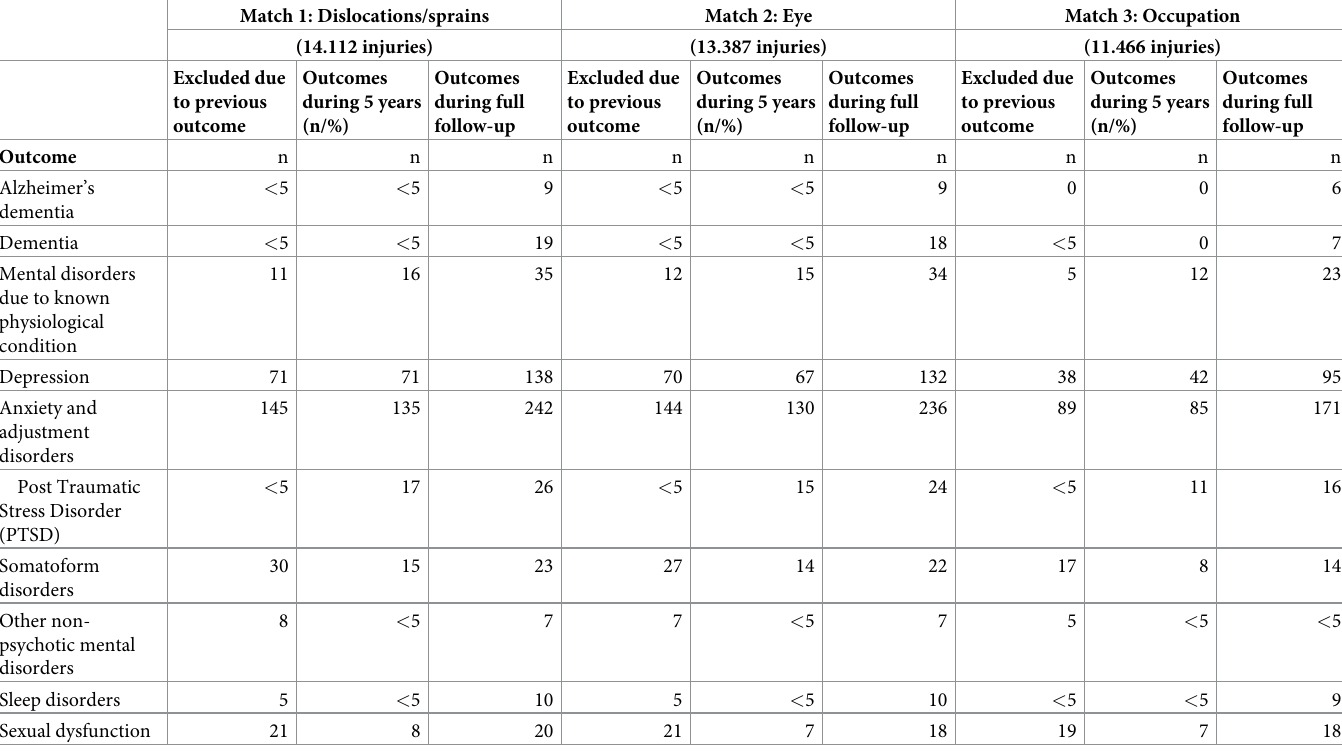
Table 1. Exclusions and outcomes for each of the three matches. Match 1: